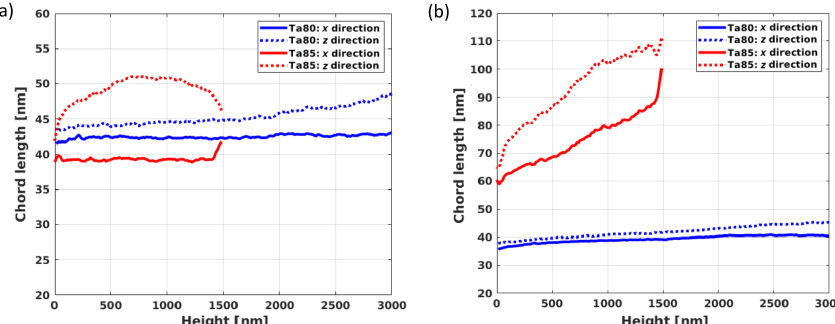
Figure 10. Slice-wise mean chord lengths in the x and z directions as functions of the height above the substrate for the solid phase and pore phase of the reconstructed FIB-SEM stacks: (a) solid phase and (b) pore phase. For Ta80, mean chord lengths do not vary strongly. Only the solid phase tends to be more elongated in the z direction with increasing height. For Ta85, both the solid phase and the pore phase are elongated in the z direction. Moreover, pore sizes clearly grow with height.